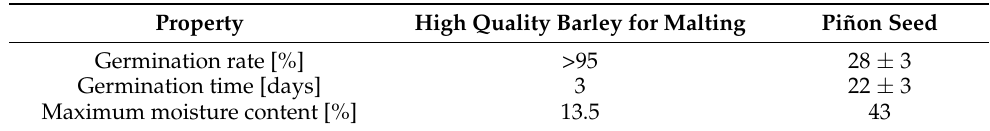
Table 2. Germination properties and maximum moisture content of barley for malting and piñon seed